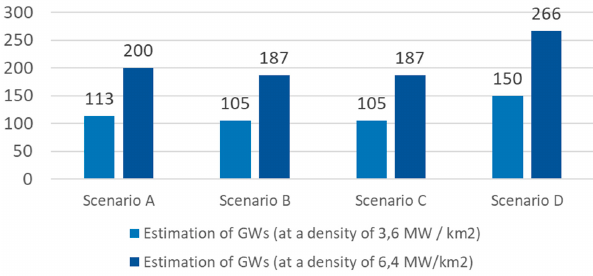
Figure 12. Estimated potential GWs: within 100 km from shore, with a water depth of –120 to –55 m (without considering multi-use in Scenarios A and B).